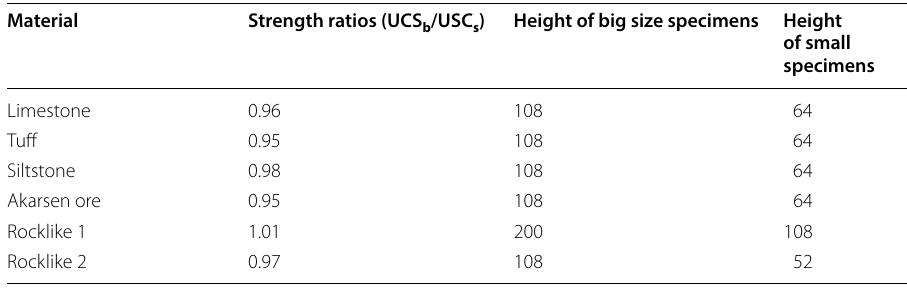
Table 4 Strength relations obtained under the condition of strain rate values selected as proportional to specimen heights (UCS : uniaxial compressive strength of big b specimens, USC : uniaxial compressive strength of small s